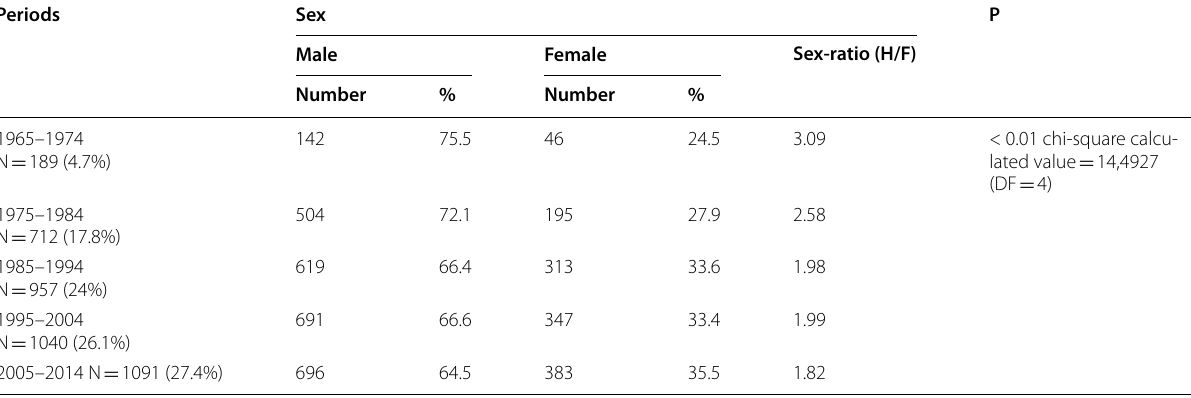
Table 1 Sex distribution of urolithiasis patients between 1965 and 2014 by decade Periods